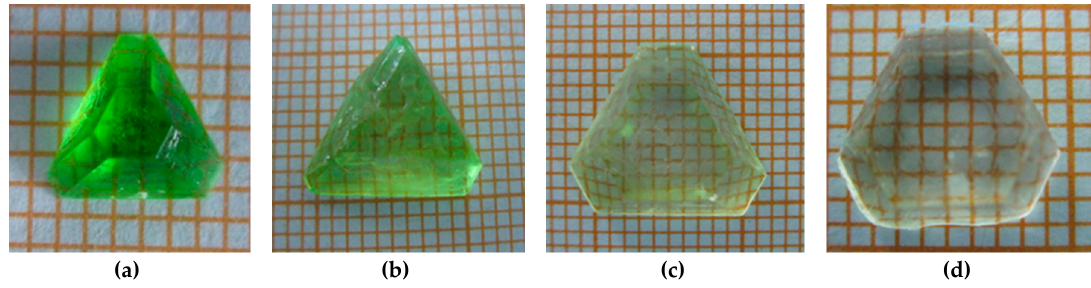
Figure 9. Photographs of crystals ( a ) ( I ), ( b ) ( II ), ( c ) ( III ), and ( d ) ( IV ).